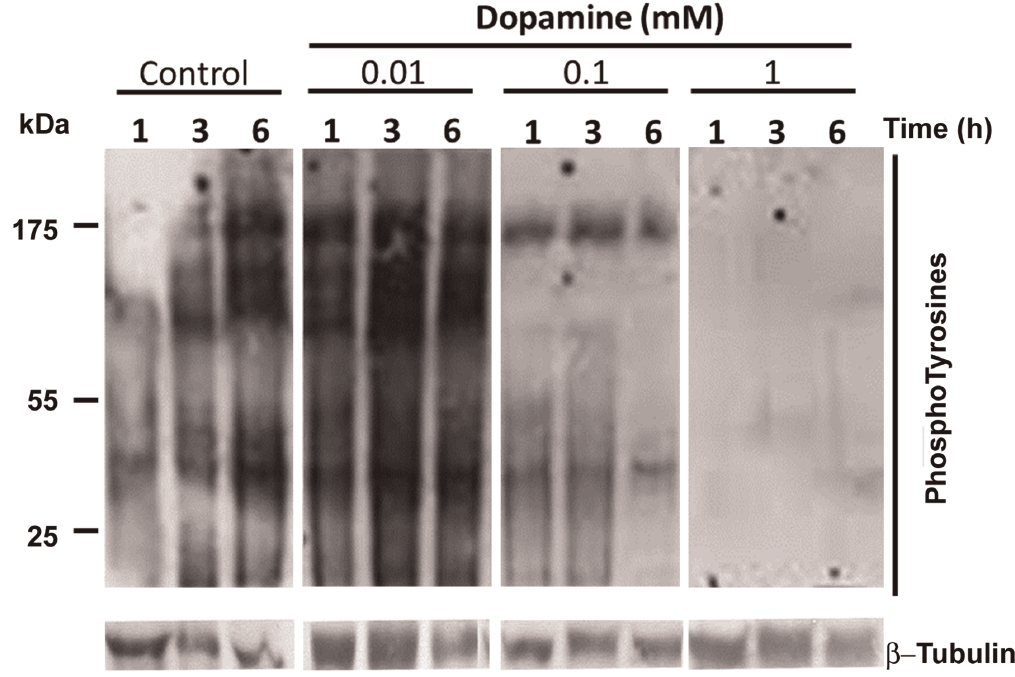
Figure 5. High levels of dopamine reduce tyrosine phosphorylation during capacitation in equine sperm. Effects of dopamine on tyrosine phosphorylation after different times of incubation and dopamine concentrations (0, 0.01, 0.1 and 1 mM) were assessed by Western blot using PY20 anti-phophotyrosine antibody. The image is representative of two independent experiments.